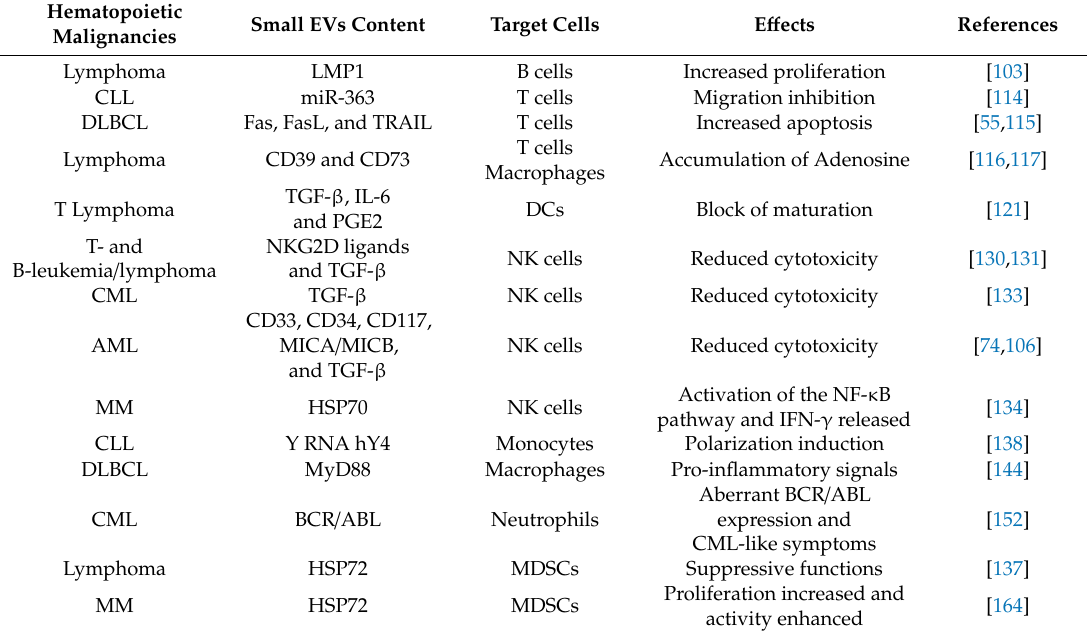
Table 1. Overview of the hematological malignancy-derived small EV functions based on the content and immune cell